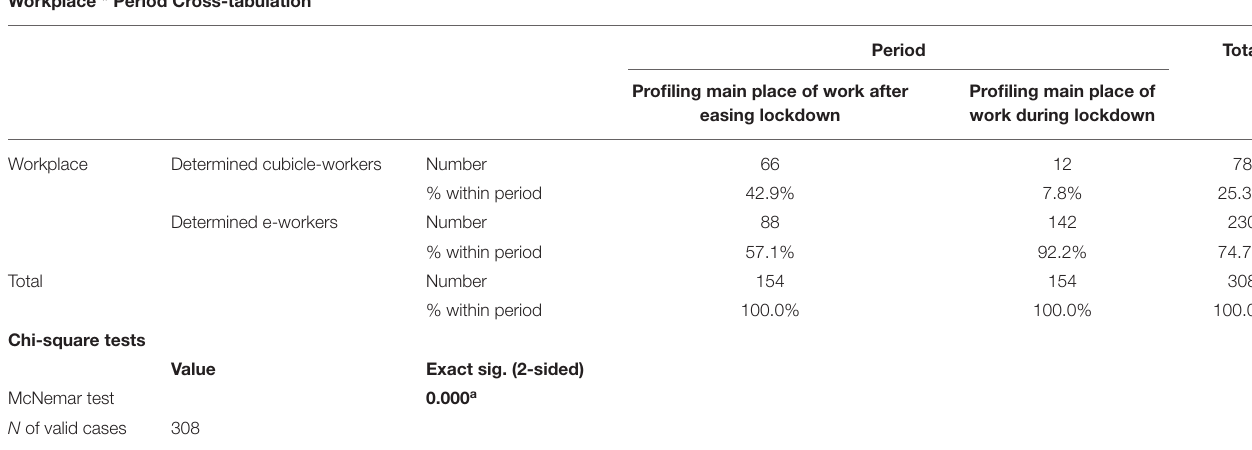
TABLE 8 | Workplace * Period Cross-tabulation and Chi Square tests. Workplace * Period Cross-tabulation